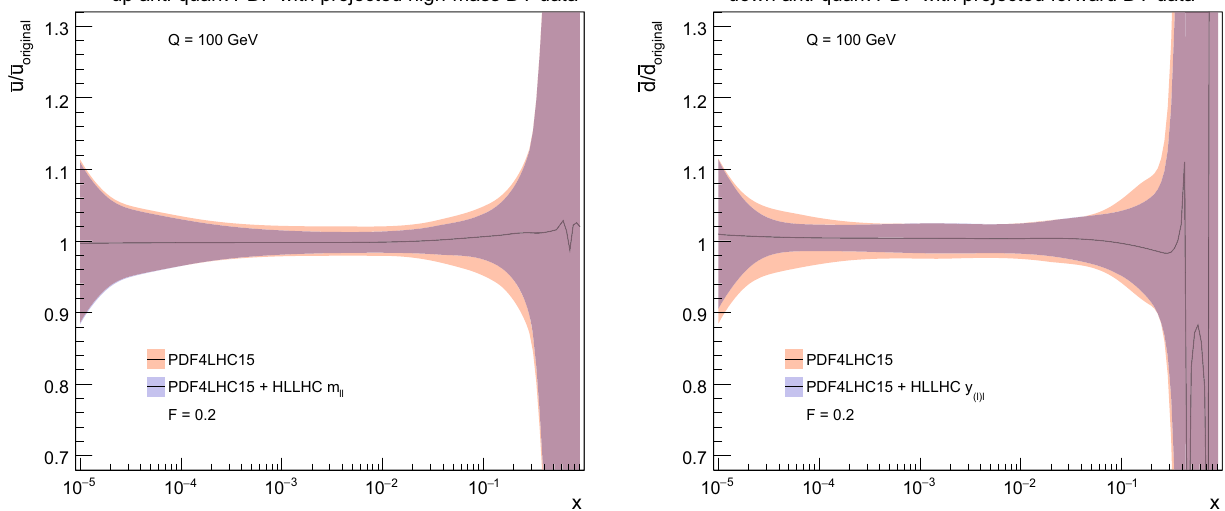
Fig. 6 The impact of the HL–LHC pseudo–data on the PDFs at Q = 100 GeV. Left: impact of high–mass Drell–Yan production on the up antiquark. Right: impact of forward W , Z process on the down antiquark